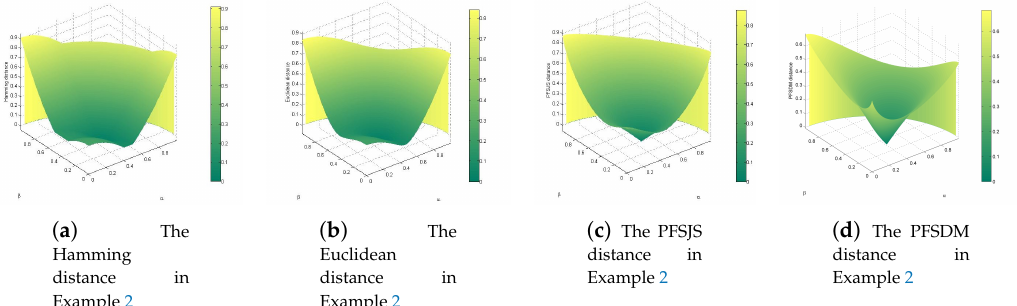
Figure 2. The results in Example